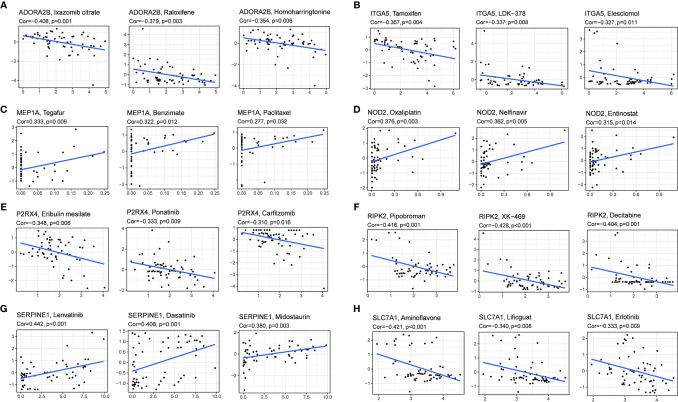
Scatter plot of relationship between prognostic gene expression and drug sensitivity. (A) ADORA2B. (B) ITGA5. (C) MEP1A. (D)NOD2. (E) P2RX4. (F) RIPK2. (G) SERPINE1. (H) SLC7A1.